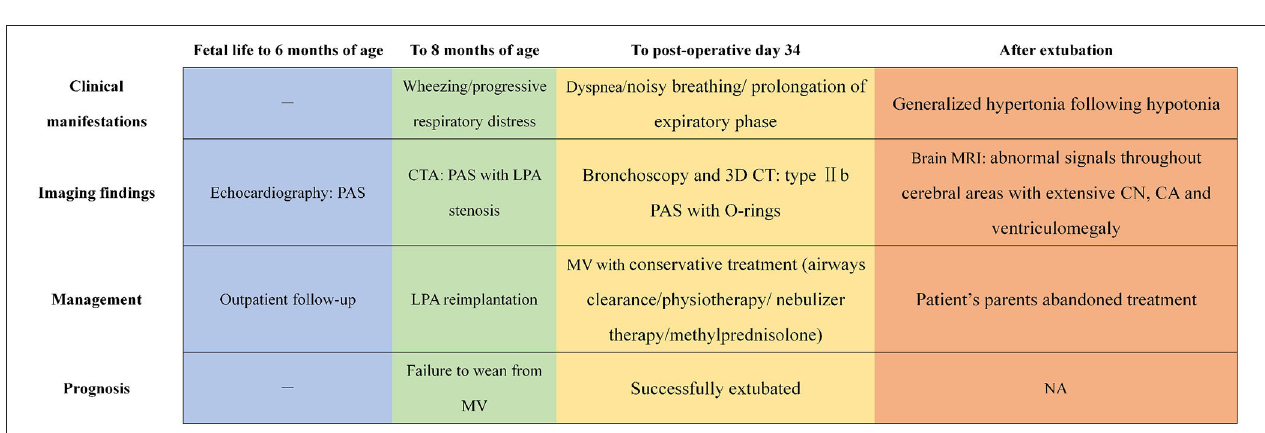
FIGURE 2 | Bronchoscopy image showing extensive airway defects accompanied by mucosal hyperemia and edema. (A,B) long-segment stenosis (yellow arrowhead) with complete tracheal cartilage rings (O-rings) (yellow arrow) at the upper and lower trachea, respectively; (C) narrowing of the carina with increased angle between LMB and RMB (yellow arrowhead); (D) stenosis at RMB (yellow arrowhead); (E) absence of the orifice of RMLB at a level where the orifice of RLLB (yellow circle) normally existed; (F) stenosis at segmental bronchi beyond RMB (yellow arrowhead); (G,H) variable narrowing in subsegmental bronchi of LLLB (yellow arrowhead). LMB, left main bronchus; RMB, right main bronchus; RMLB, right middle lobe bronchus; RLLB, right lower lobe bronchus; LLLB, left lower lobe bronchus.